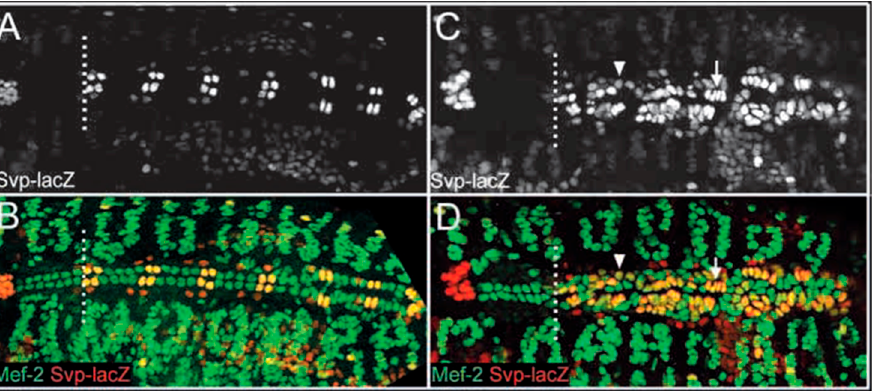
Figure 4. Pointed embryos exhibit a significant increase in Svp-positive cardioblasts. Dorsal views of stage 16 wild-type ( A , B ) and pnt ( C , D ) embryos labeled for Svp-lacZ ( A , C ), and Svp-lacZ and Mef-2 ( B , D ). ( A , B ) In wild-type embryos, 12 Svp-negative cardioblasts arise anterior to the first Svp-positive cardioblast (broken white line); seven of these cardioblasts are visible in A and B. Posterior to this location, there is a reiterative pattern of two Svp-lacZ positive cardioblasts (yellow/orange) and four Svp-lacZ negative cardioblasts (green) per hemisegment. ( C , D ) In pnt embryos, cardioblast development anterior to the first Svp-positive cardioblast (broken white line) appears normal. How- ever, many ectopic cardioblasts are found posterior to this location and the majority of these cells express Svp-lacZ at high (arrow) or moderate levels (arrowhead). The broken white line separates the anterior heart domain from the posterior seven heart segments; anterior is towards the left [5].